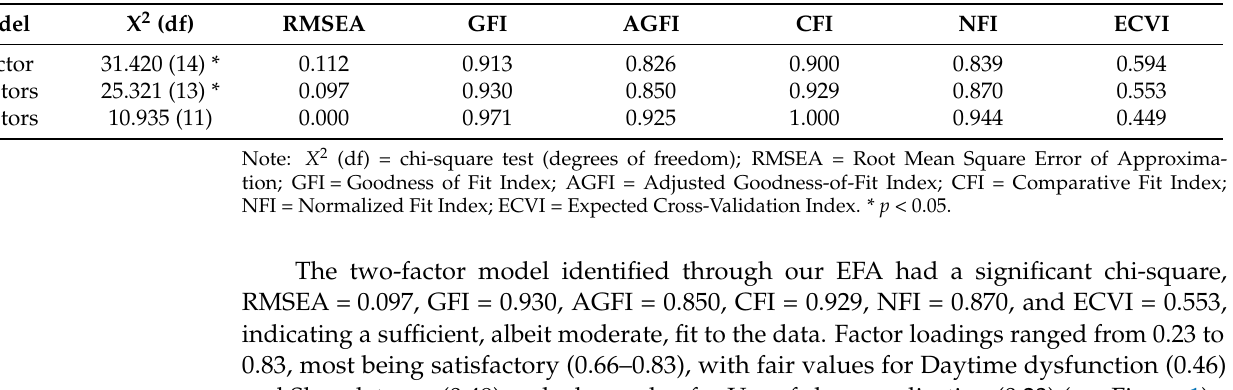
Table 4. Confirmatory factor analysis for PSQI.